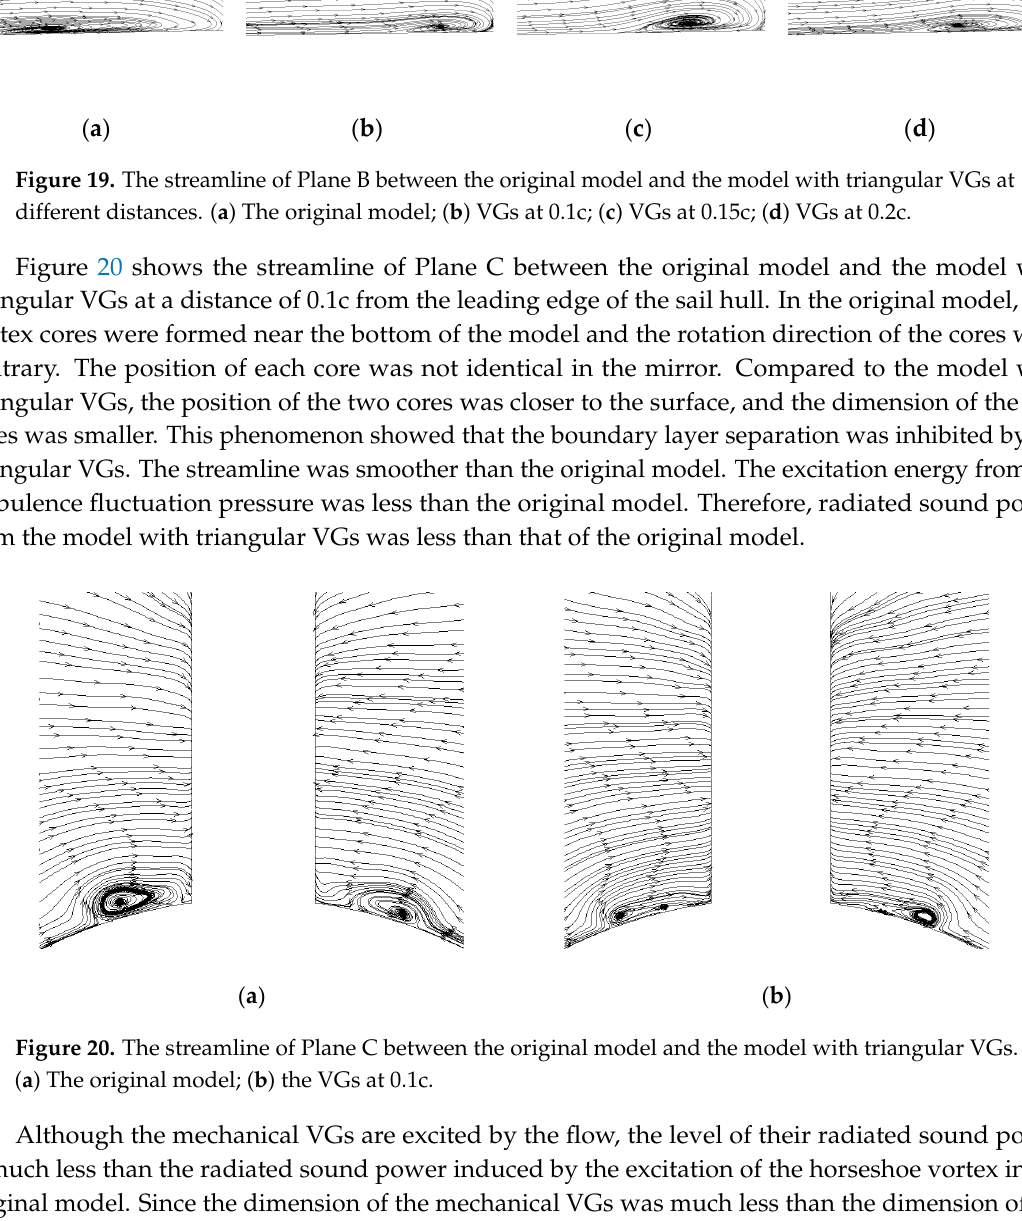
( c ) Figure 18. The contour map at the leading edge of Plane B of the model with triangular VGs at different distances. ( a )0.1c; ( b )0.15c; ( c ) 0.2c. Compared to the original model, the triangular VGs stirred the turbulence. The pressure gradient stopped growing when the points were close to the leading edge. In other models, there exists turbulent disorders nearby the triangular VGs. The two new cores revealed the change in the pressure gradient, that is, one is adverse and the other is positive. The first core was the heads of triangular VGs, and the second core was the tails of triangular VGs. Compared to Figure 11, the movement of the triangular VGs significantly changed the turbulence. We observed that the vortices from the VGs reduced the intensity of adverse pressure gradients at the leading edge of the sail hull. With the distance increase, the intensity changed and the turbulent disturbance became more obvious. The origin of the horseshoe vortex was intensively destroyed and the intensity of the horseshoe vortex was weakened. This phenomenon showed that the flow-induced noise by the excitation of the horseshoe vortex would be further reduced if the triangular VGs are moved far from the leading edge. Figure 19 shows the streamline comparison between the original model and the model with triangular VGs at different distances from the leading edge. Compared to the original model, we